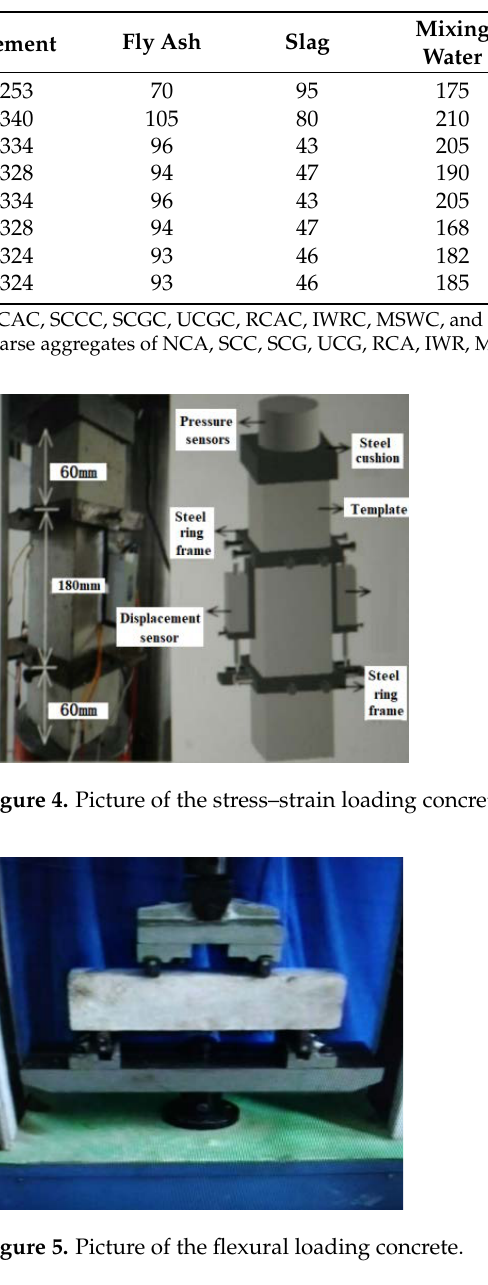
Table 4. Mix ratio of the different kinds of coarse aggregate concrete (kg/m 3 ).